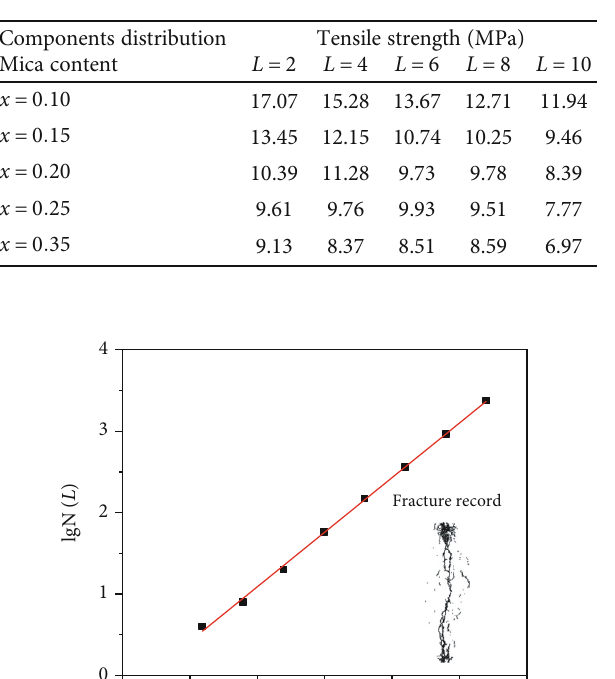
Figure 7: Image of di ff erent fabric granite specimens. Table 3: Results of splitting strength of specimens with di ff erent fabrics.